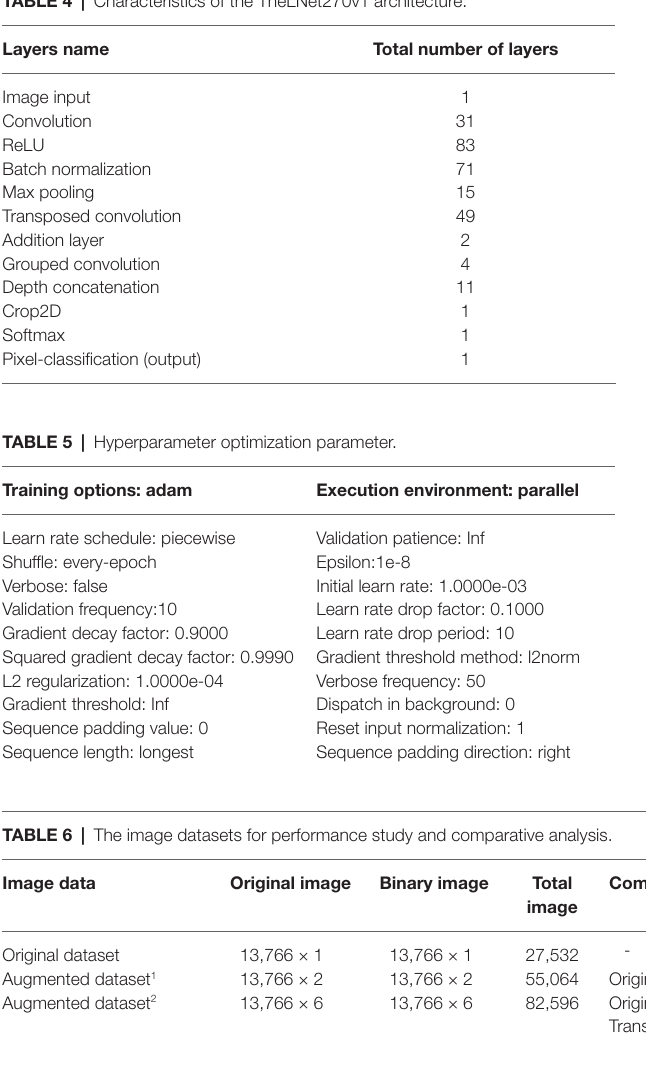
TABLE 4 | Characteristics of the TheLNet270v1 architecture.